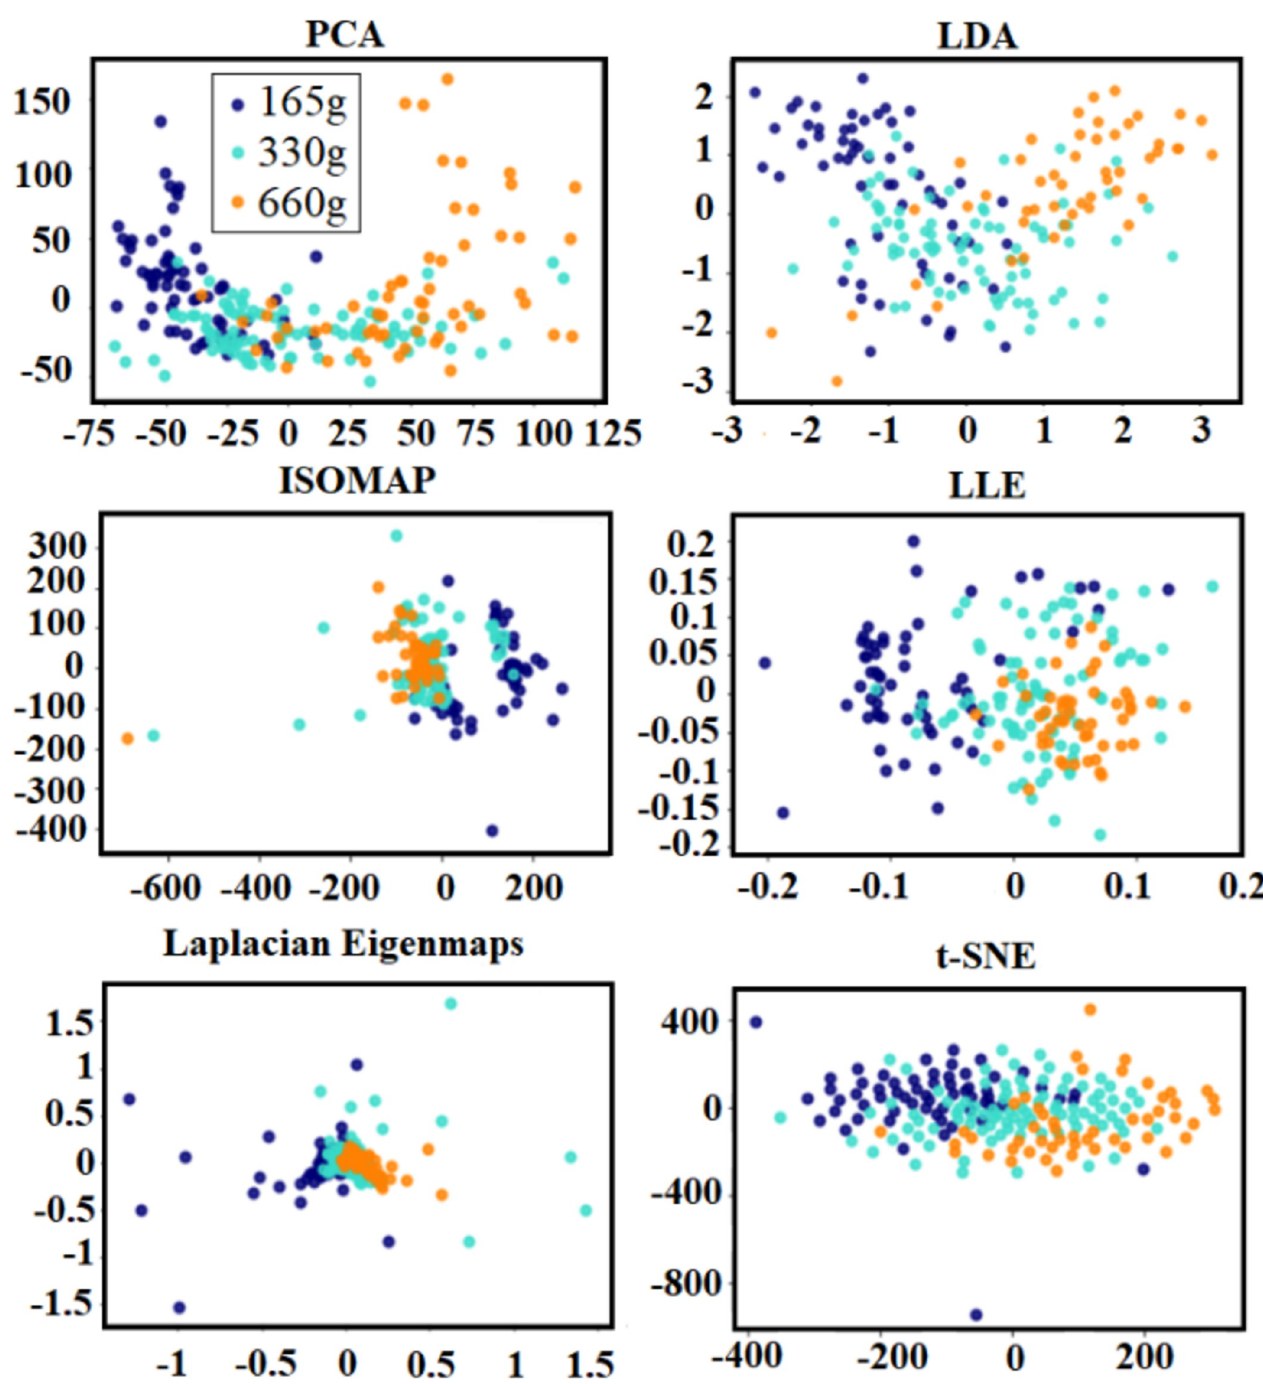
Fig 7. Visualization of the embedding process. EMG visualization using the 2 most prominent components of different dimensionality-reduction technique (The x-axis is the most prominent component, and the y-axis is the second most prominent component).